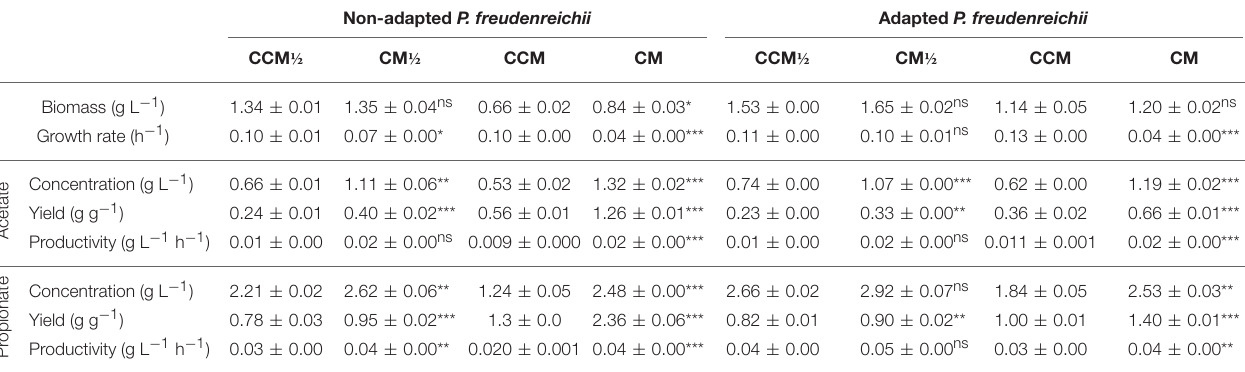
TABLE 2 | Kinetics of the fermentations conducted with adapted and non-adapted Propionibacterium freudenreichii .